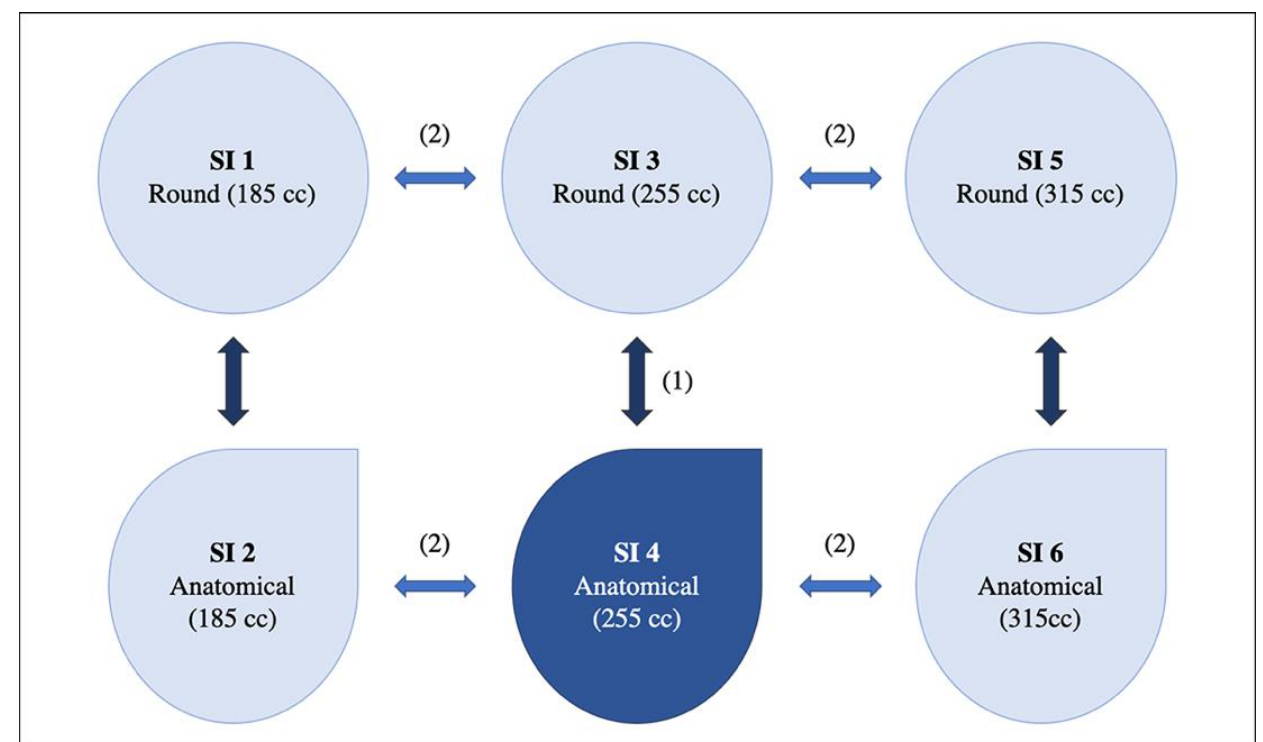
Figure 1. Schematic example of implant selection. First, the definitive implant was chosen during preoperative consultation. Thereafter, the implant of the contrary shape and same volume was chosen and finally, the smaller and bigger pairs of implants were chosen for each shape. In this example, an anatomical implant with 255 cc of volume was chosen as definitive implant. SI 1, 3, and 5 were round implants and SI 2, 4, and 6 were anatomical implants. SI = study implant. Dark blue: specific implant selected in the preoperative consultation. (1) Selection of the round correlate with same base +/ − 5 mm, volume and projection. (2) Selection of the smaller/larger projection with same shape/base.